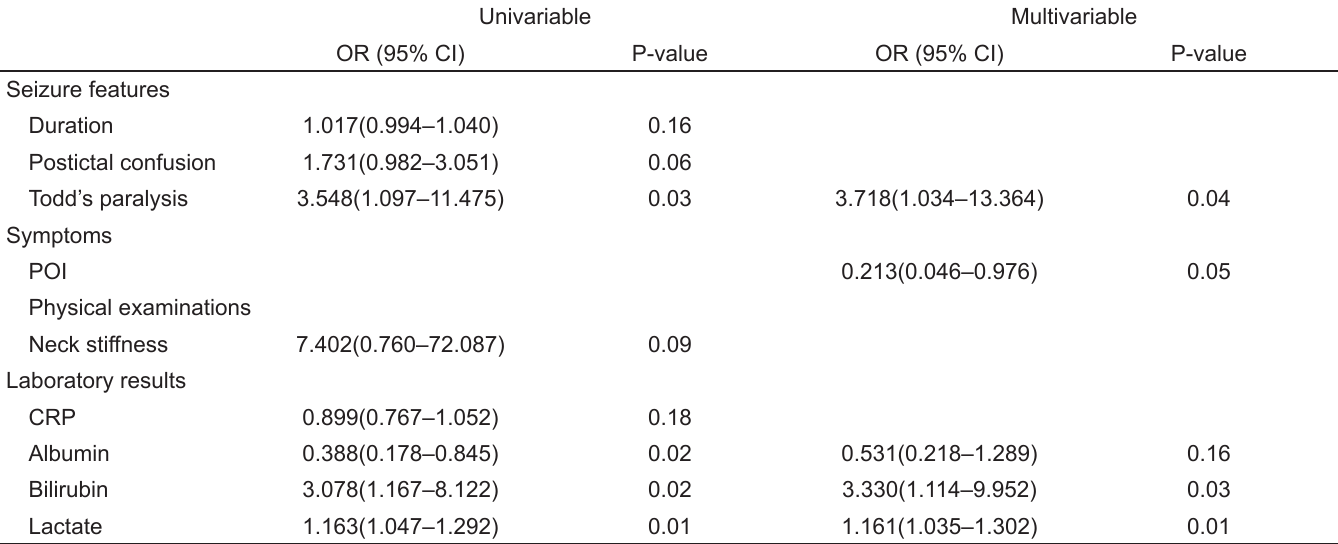
Table 3. Univariable and multivariable logistic regression analyses of risk factors for neuroimaging abnormalities in pediatric afebrile seizure patients.